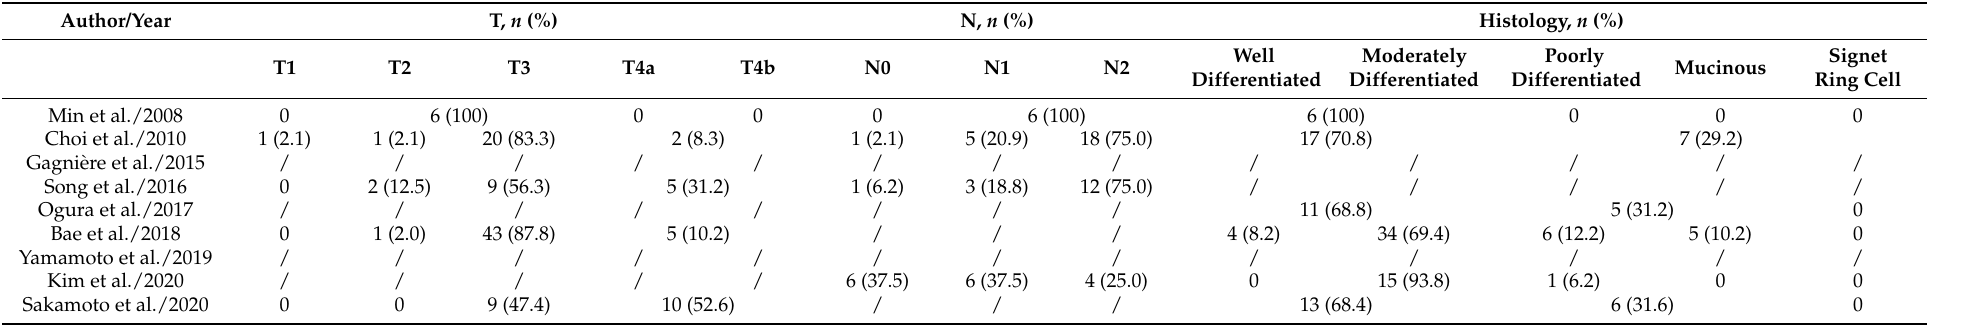
Table 2. Primary CRC